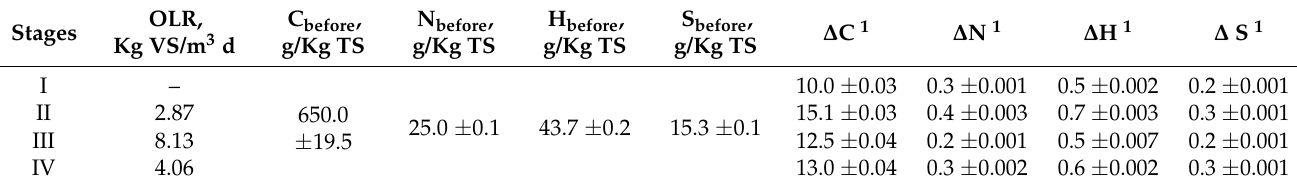
Table 7. Change in the elemental composition of the substrate at varying